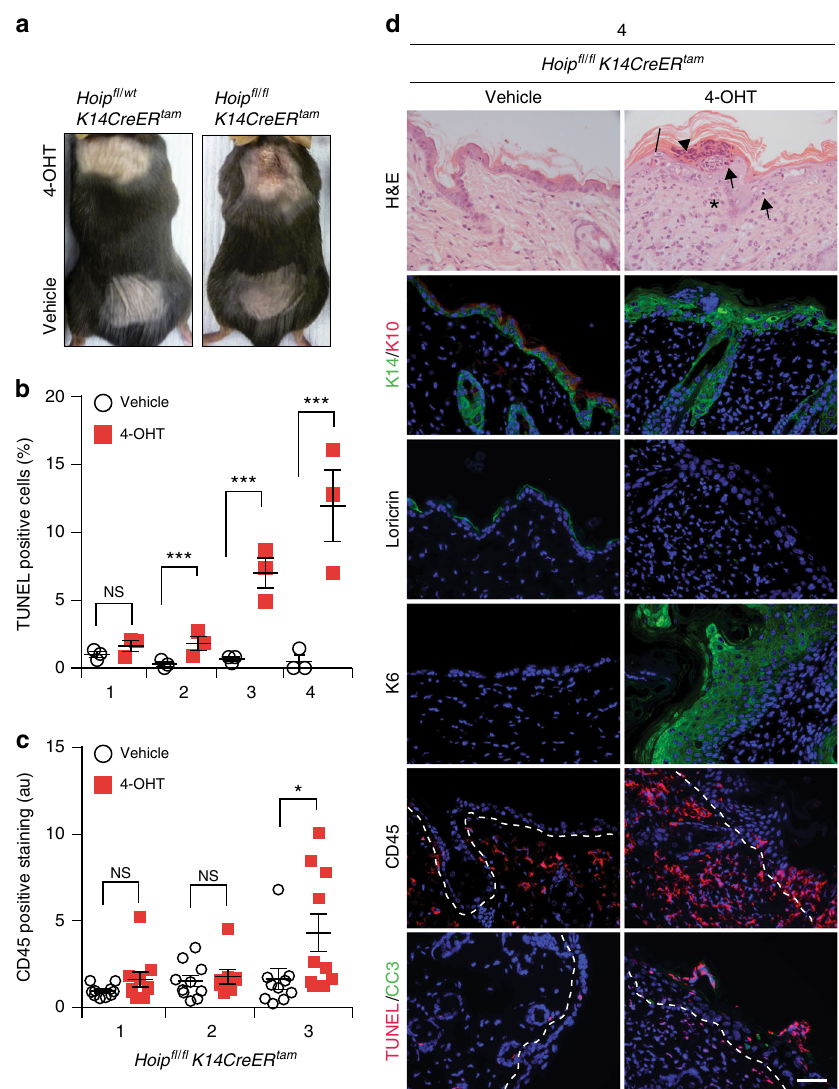
Fig. 5 Adult Hoip E-KO mice suffer from cell death-induced dermatitis. a Representative images of mice of the indicated genotypes ( n = 8 mice per genotype). Animals were treated with vehicle or 4-OHT every other day for a total of four doses. b Quanti fi cation of TUNEL-positive cells in skin sections of Hoip fl / fl K14CreER tam mice after one, two, three or four treatments with vehicle or 4-OHT. Data are presented as mean values ± s.e.m. ( n = 3 per genotype). *** P ≤ 0.001, NS: not signi fi cant. c Quanti fi cation of CD45 staining in skin sections from Hoip fl / fl K14CreER tam mice treated as in b was performed by measuring overall fl uorescence intensity using ImageJ. Results are presented as mean values± s.e.m. ( n = 3 mice per genotype). * P ≤ 0.05, NS: not signi fi cant. au: arbitrary units. d Representative images of skin sections stained with H&E, the indicated antibodies and TUNEL from mice of the indicated genotypes ( n = 3 mice per genotype) after four 4-OHT treatments. Arrows: pyknotic nuclei, stars: immune cell in fi ltrates, arrowhead: parakeratosis and black bar: hyperkeratosis. Nuclei were stained with DAPI (blue). White dashed lines indicate boundary of epidermis (above) and dermis (below). Scale bars, 50 µ